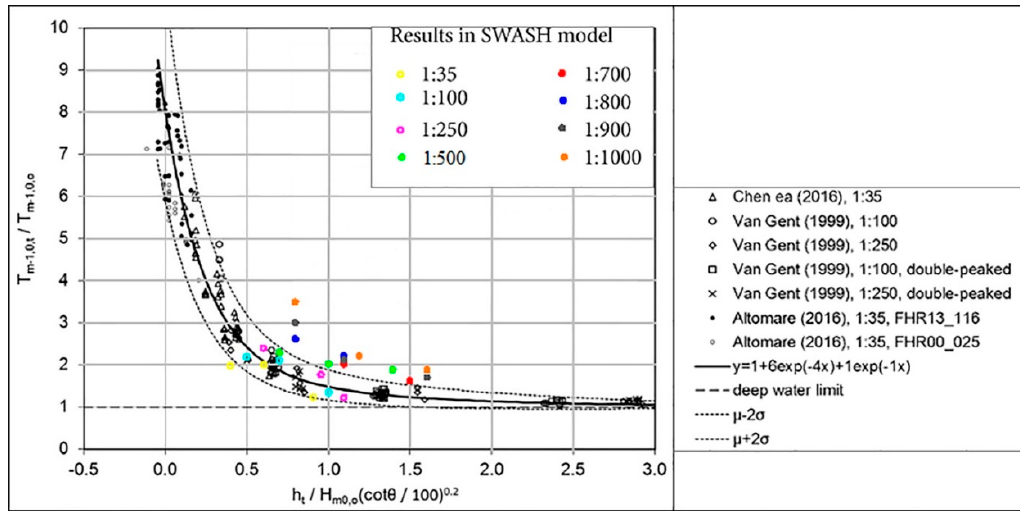
Figure 14. Compare SWASH results for very gently sloping foreshore and evolution of wave period of Hofland [11].